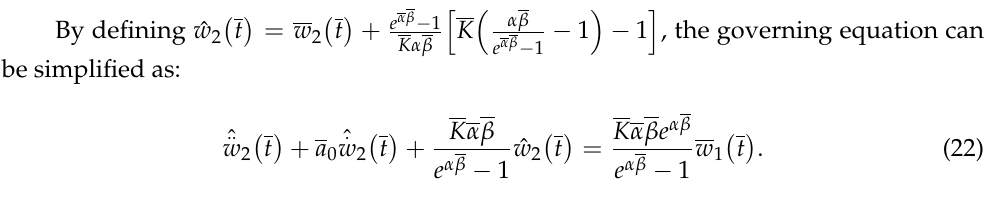
Figure 2. Schematic of the fiber-mass system translating in a linear temperature field. ( a ) Reference state; ( b ) Current state. A mass block with a mass of m is attached to the free end of the LCE fiber connected to a frame that ignores gravity. The motion of the fiber-mass system is determined by the displacement, velocity, and acceleration of the mass connected to the end of the LCE fiber, as well as the displacement of the frame attached to the other end of the LCE